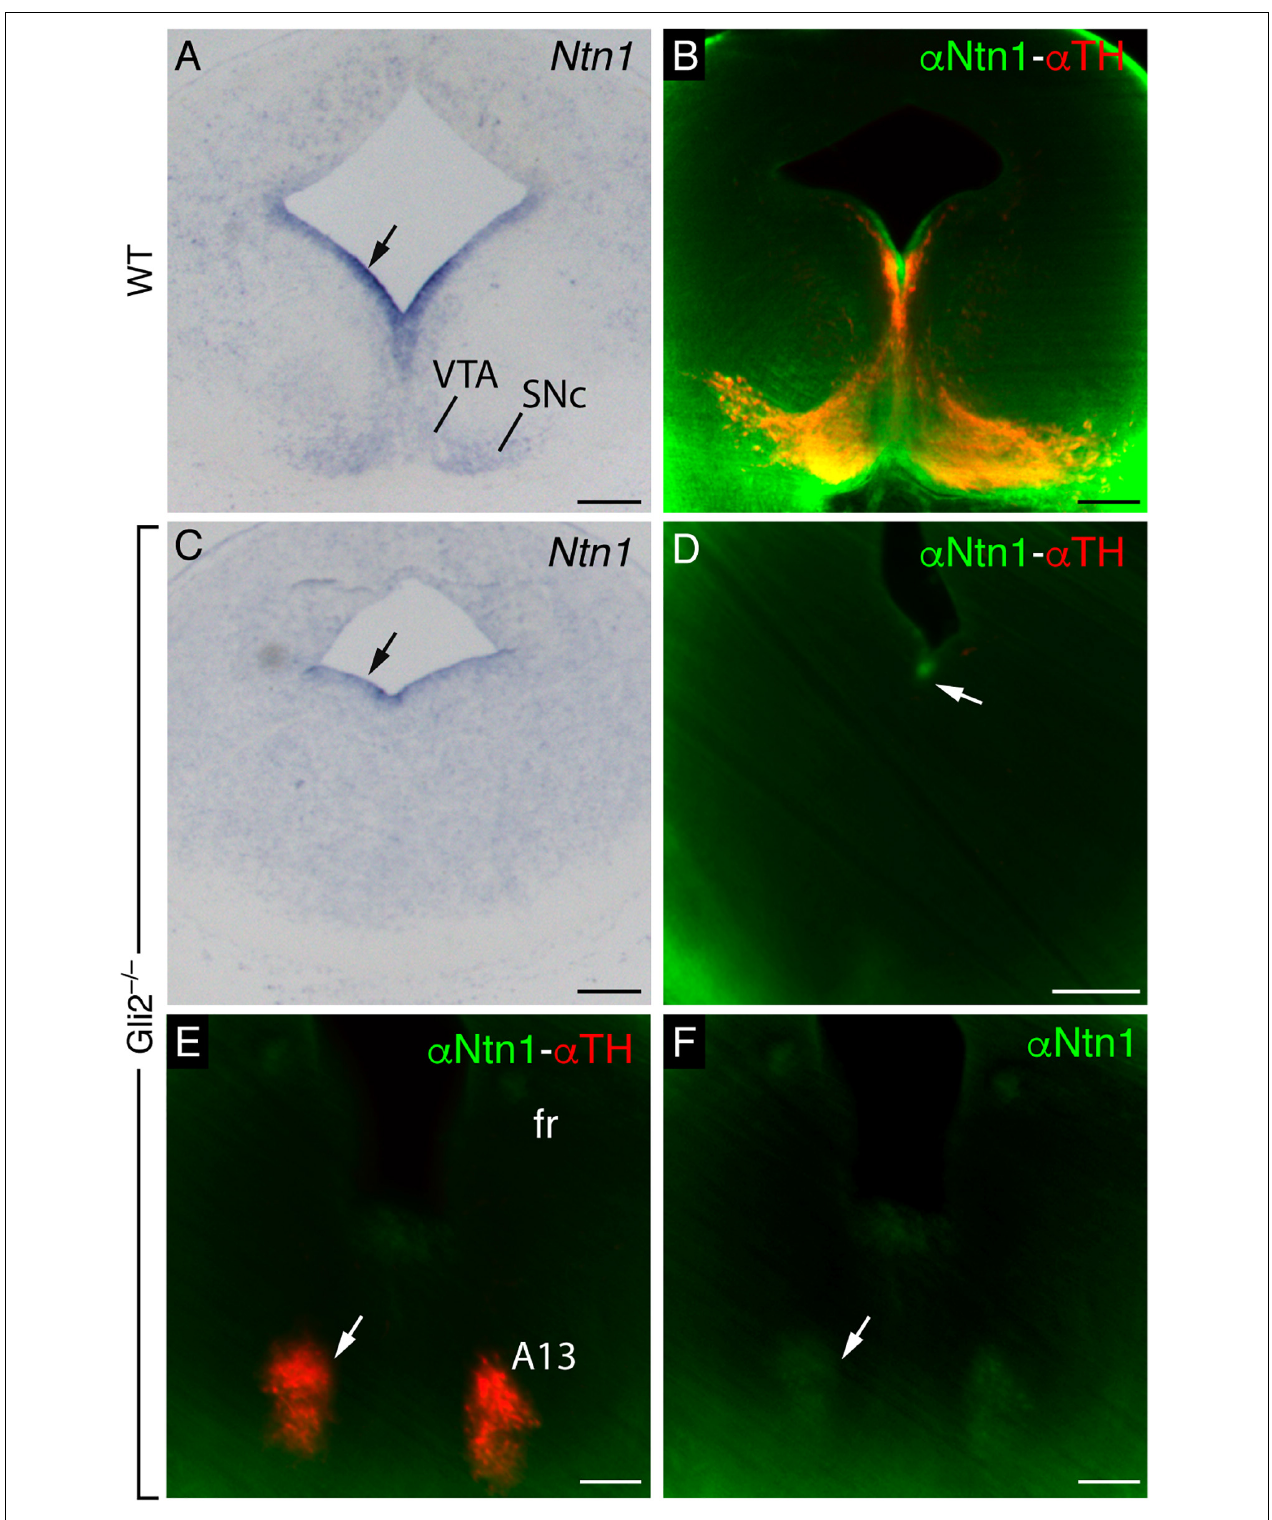
FIGURE 5 | Ntn1 mRNA and NTN1 protein distribution in E13.5 wild type and Gli2 − / − mutant. (A,B) Midbrain coronal sections of E13.5 wild-type brains labeled with Ntn1 in situ hybridization (A) and light-sheet fluorescence microscopy images with NTN1 and TH in toto IHC (B) . (C–F) Coronal sections of E13.5 Gli2 − / − brains labeled with Ntn1 in situ hybridization (C) and with NTN1 and TH IHC by the iDISCO protocol (D–F) . Midbrain level in (C,D) and diencephalic level in (E,F) . Abbreviations: A13, A13 dopaminergic population; SNc, substantia nigra pars compacta; VTA, ventral tegmental area. Scale bar: 200 µ m.